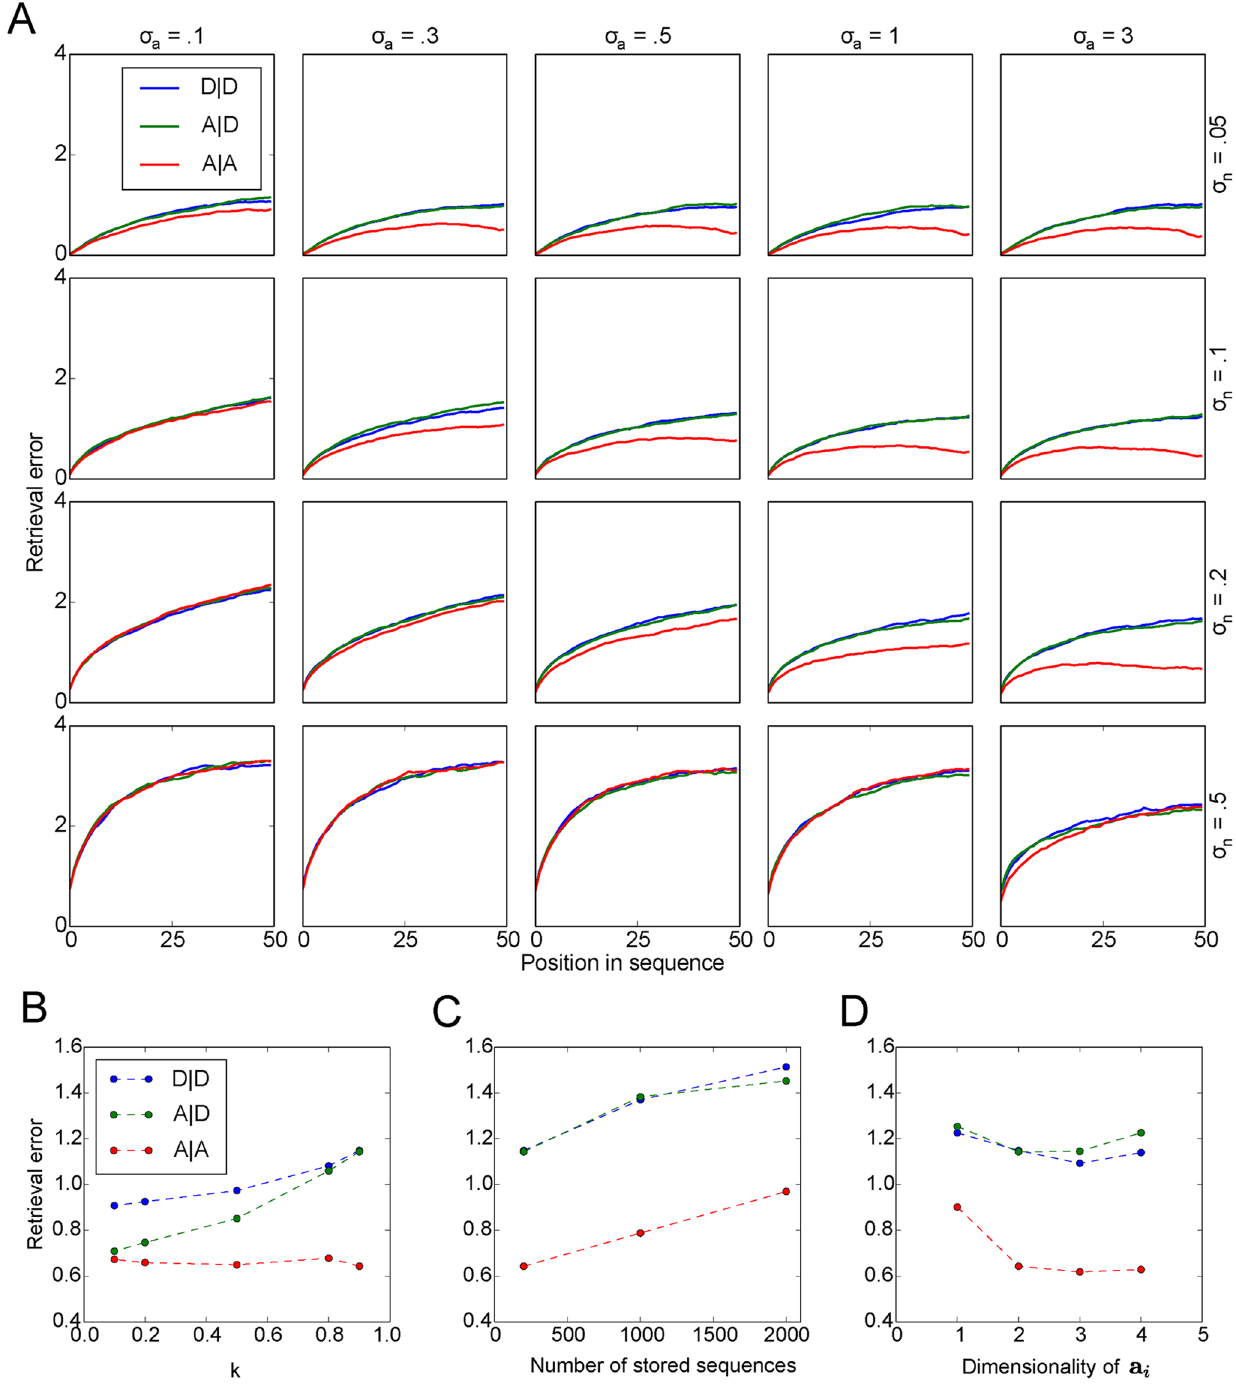
Fig 6. Sequential memory retrieval in asymptomatic and depressive states. A: Retrieval performance for the three cases A|A, A|D, D|D (indicated by color) at different levels of pattern separation σ (left to right) and retrieval noise σ (top to bottom). B: The duration of depressive episode affects the a n retrieval performance of A|D and D|D. Duration is measured by the fraction of memories stored in the depressive episode k (Eq 12). C: Increasing the number of stored sequences negatively impacts the retrieval performance in all cases, while the difference are preserved. D: Increasing the dimensionality of the pattern separation vector, up to a certain point, increases the difference between the A|A and the other cases. Values in B, C and D are calculated based on the 30 th element in the sequence ( σ a = 1, σ n = 0.1). For A,B,C: a :2-D; for A,C,D: k = 0.9; for A,B,D: 200 stored sequences in both asymptomatic and depressive state